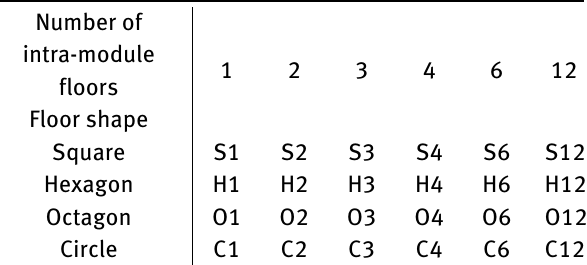
Table 1: Twenty-four diagrid structures with different diagonal inclination and floor